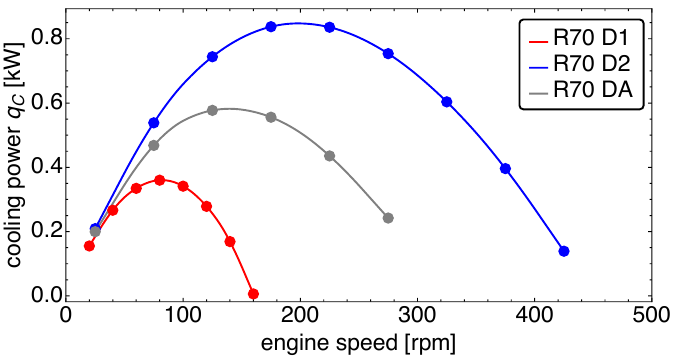
Figure 5. The cooling power for r = 0.7 regeneration extent is shown as a function of the engine speed for the three engine designs D1, D2, and DA. The maximal cooling power for the D1 design is less than half as large as that for the D2